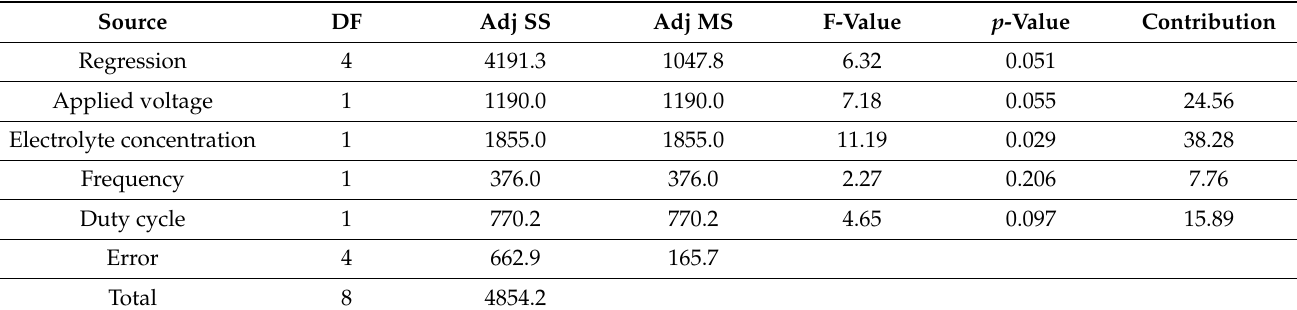
Table 10. ANOVA for conicity of quenched tool.